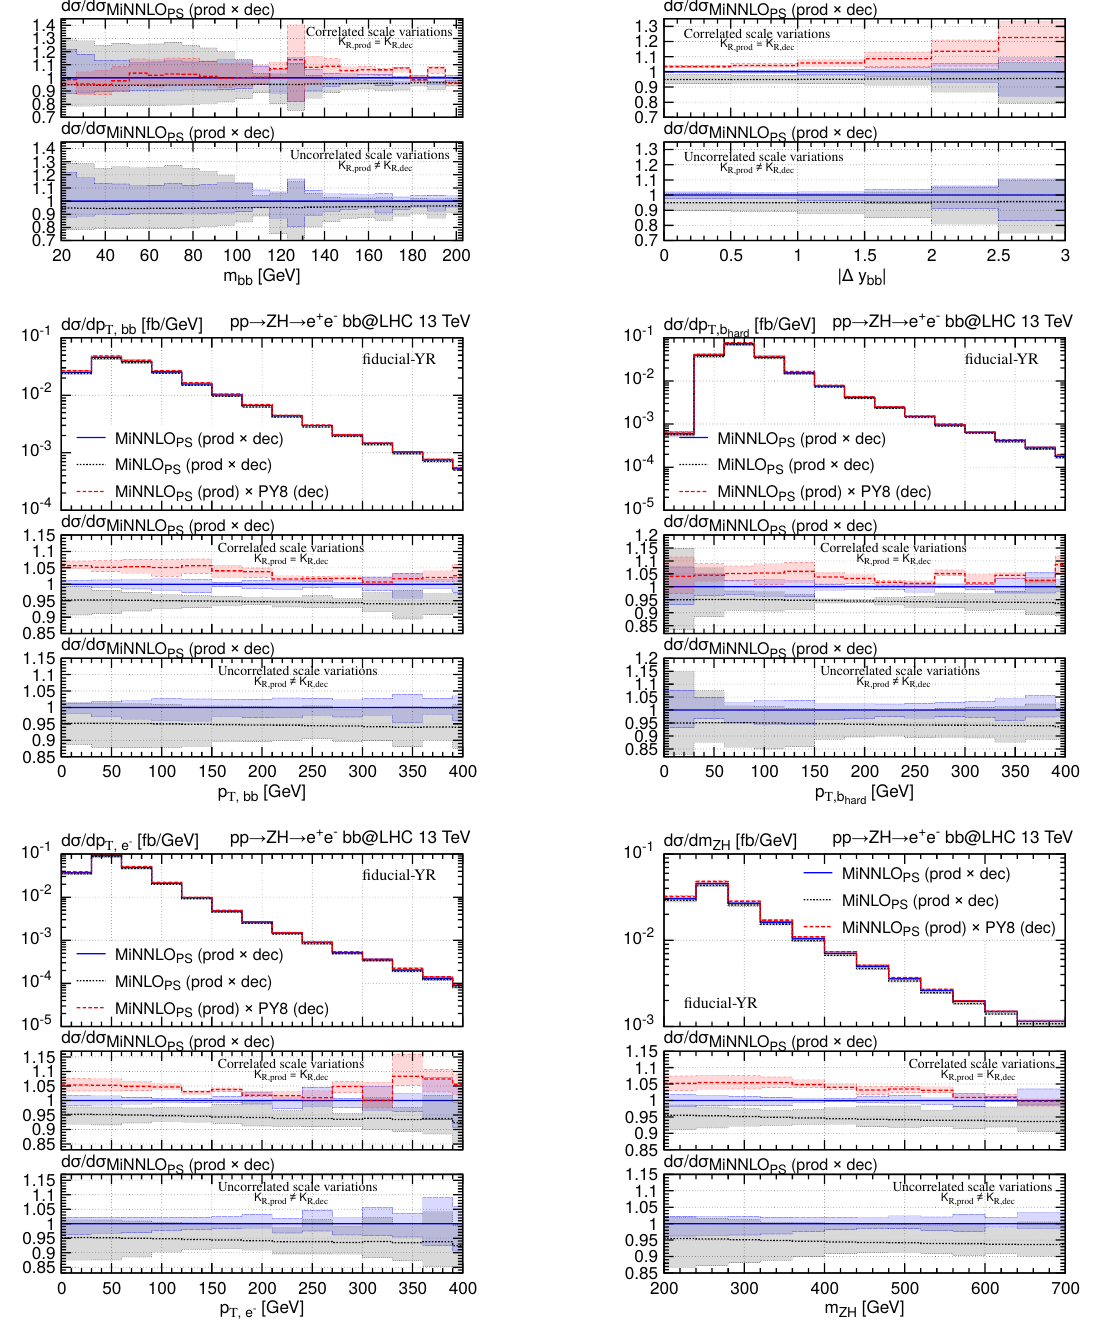
Figure 5 . Differential distributions for e + e − b ¯ b production with fiducial-YR cuts. K R , prod and K R , dec refer to the variation factors of the renormalization scales of production and decay,